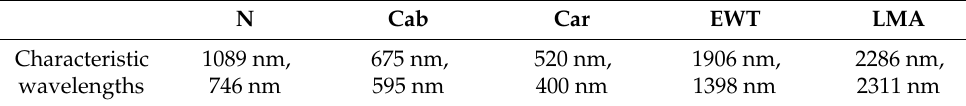
Table 3. Selected characteristic wavelengths of leaf biochemical parameters.